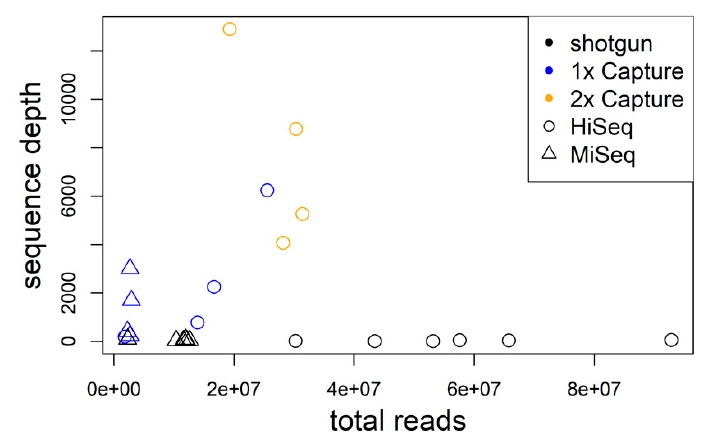
Figure 2. The average genome sequence depth significantly increases with the number of total sequence reads for libraries enriched using hybrid capture. Shotgun data are shown for comparison in black.